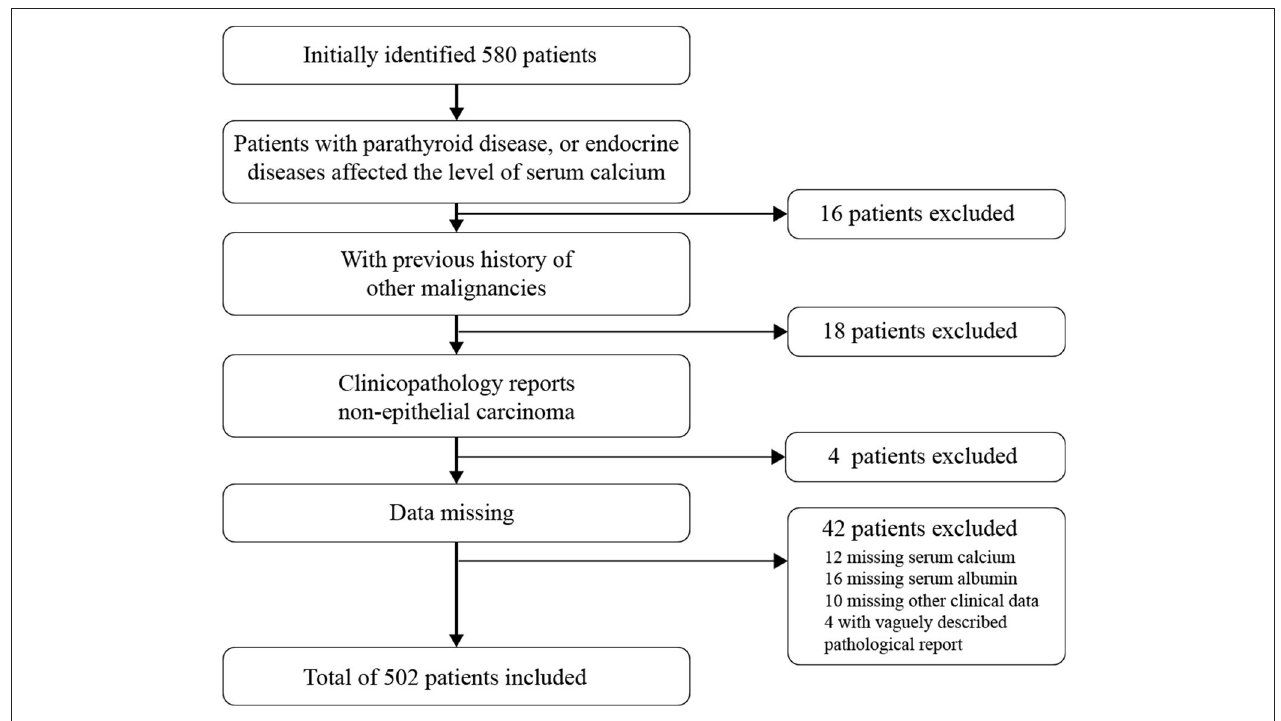
FIGURE 1 | Patient selection for EC